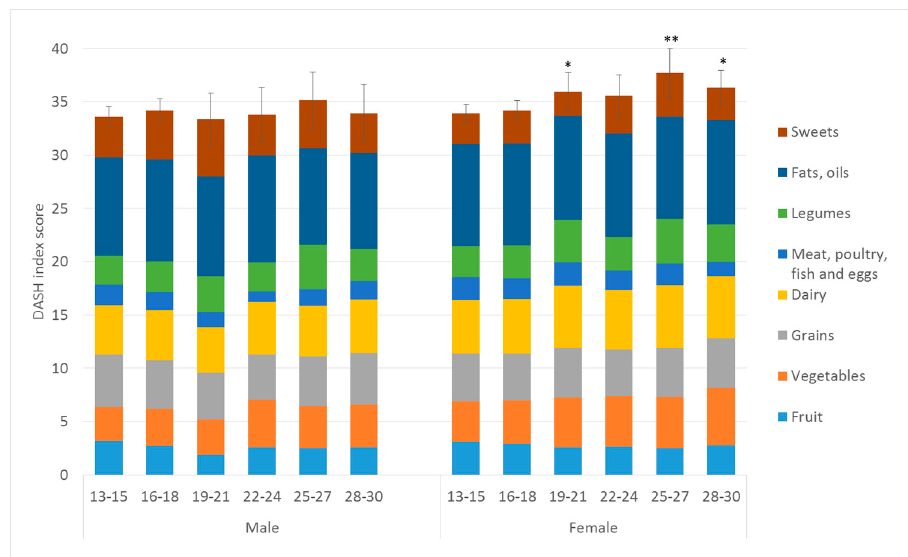
Figure 1. Diet quality (DASH index) by age category and sex for the NDNS Rolling Programme years 1–8. Total DASH scores are out of a maximum of 80 points, with each component score having a maximum of 10 points. Scores were adjusted for ethnicity and survey year. Errors bar indicate a 95% confidence interval of the total DASH score. ** p < 0.01, * p < 0.05 for the difference between the total DASH score for each age category compared to the reference category (age 13–15).